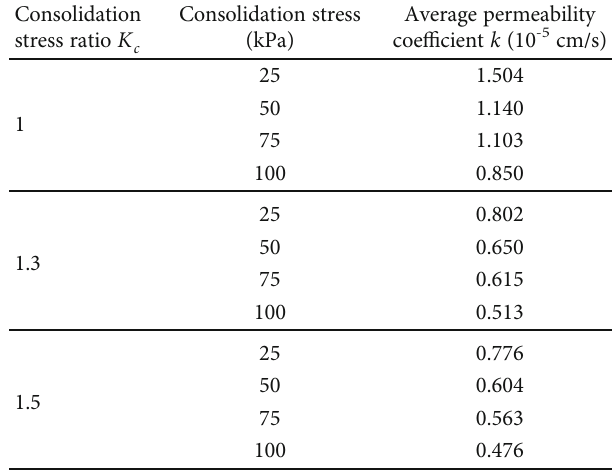
Figure 12: The relation curve between soil ultimate compression and stress di ff erence. Table 7: Permeability coe ffi cient at various consolidation